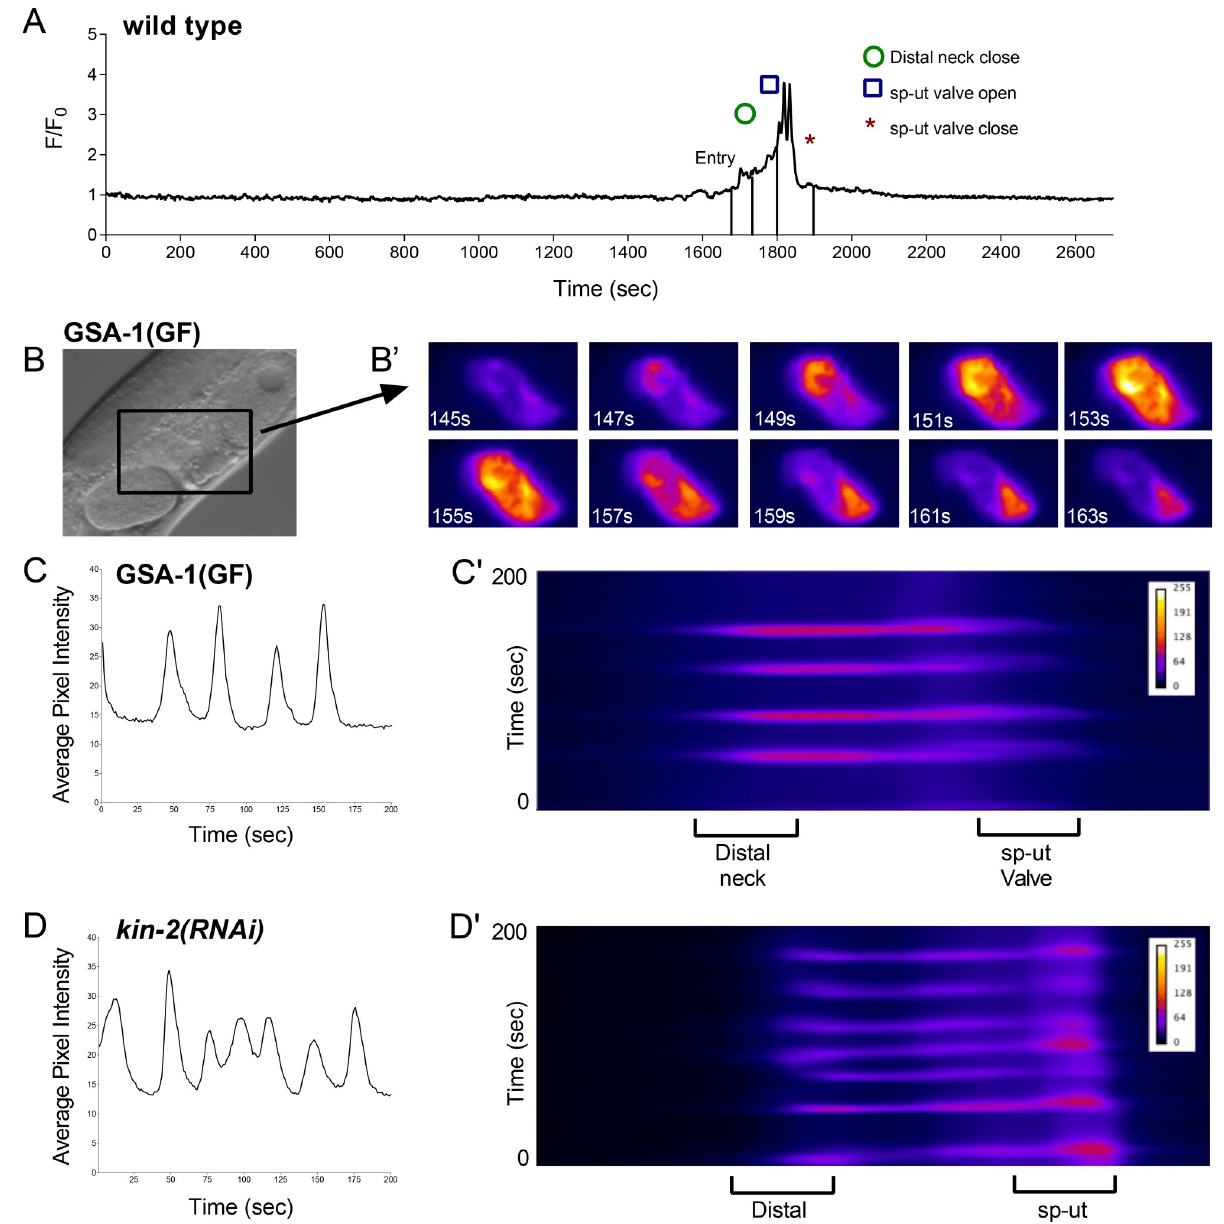
Fig 3. GSA-1(GF) and knockdown of KIN-2/PKA-R induce Ca 2+ signaling in an empty spermatheca. (A) Normalized Ca 2+ trace of a wild type ovulation before, during, and after transit. Ca 2+ signal does not rise above basal levels before or after the transit. Time of entry, distal neck closure, and time the sp-ut valve opens and closes are indicated. (B) DIC image of a GSA-1(GF) animal; the spermatheca is indicated by a box. (B’) Ca 2+ signaling in the unoccupied GSA-1(GF) spermatheca shown in B at an arbitrary timepoint before an ovulation event. Ca 2+ repeatedly increases, peaks, and then drops to baseline levels. These pulses travel from the distal spermatheca through the bag to the sp-ut valve (S5 Movie). Average pixel intensity trace of the Ca 2+ signal (C) and kymogram (C’) of the GSA-1(GF) spermatheca are shown. Knockdown of KIN-2 with RNAi results in a similarly pulsing unoccupied spermatheca, as shown by the average pixel intensity trace of the Ca 2+ signal (D) and kymogram (D’) of a kin-2(RNAi) animal. an important regulator of spermathecal contractility. Depletion of pde-6 resulted in 56% (n = 50) of animals with embryos retained in the spermatheca (Fig 5A). To study the effects of PDE-6 on ovulations and Ca 2+ dynamics, we collected time-lapse images of GCaMP3 animals